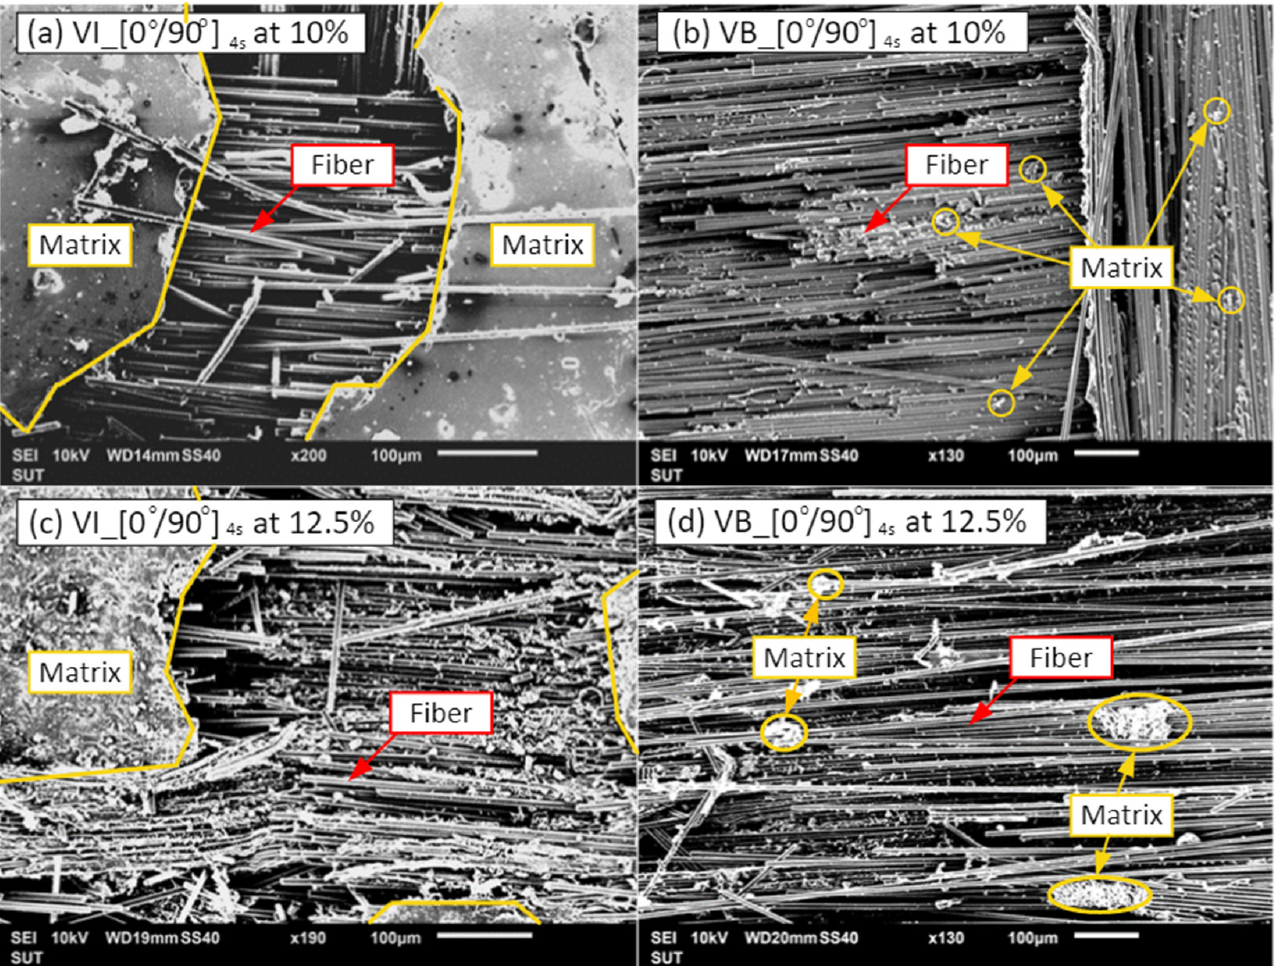
Figure 13. SEM of fracture specimens of [0 ◦ /90 ◦ ] 4s with: ( a ) 10 wt% of the graphite filler under a vacuum infusion process; ( b ) 10 wt% of the graphite filler under a vacuum bagging process; ( c ) 12.5 wt% of the graphite filler under a vacuum infusion process; and ( d ) 12.5 wt% of the graphite filler under a vacuum bagging process.